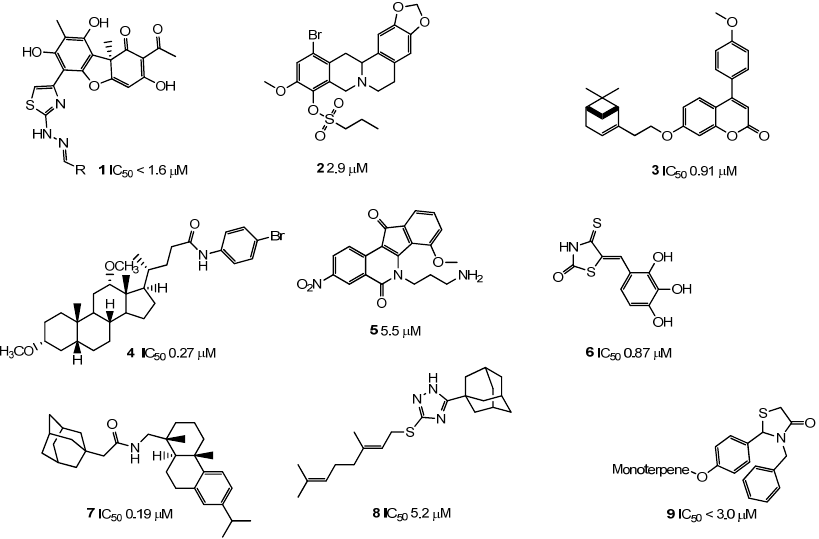
Figure 1. Structure of natural, semi-natural and synthetic TDP1 inhibitors.